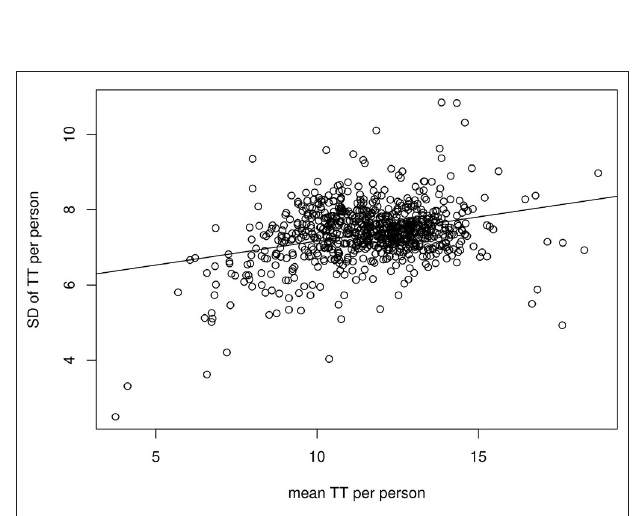
FIGURE 8 | Linear regression analysis of TT and its respective TTSD of all files included in the